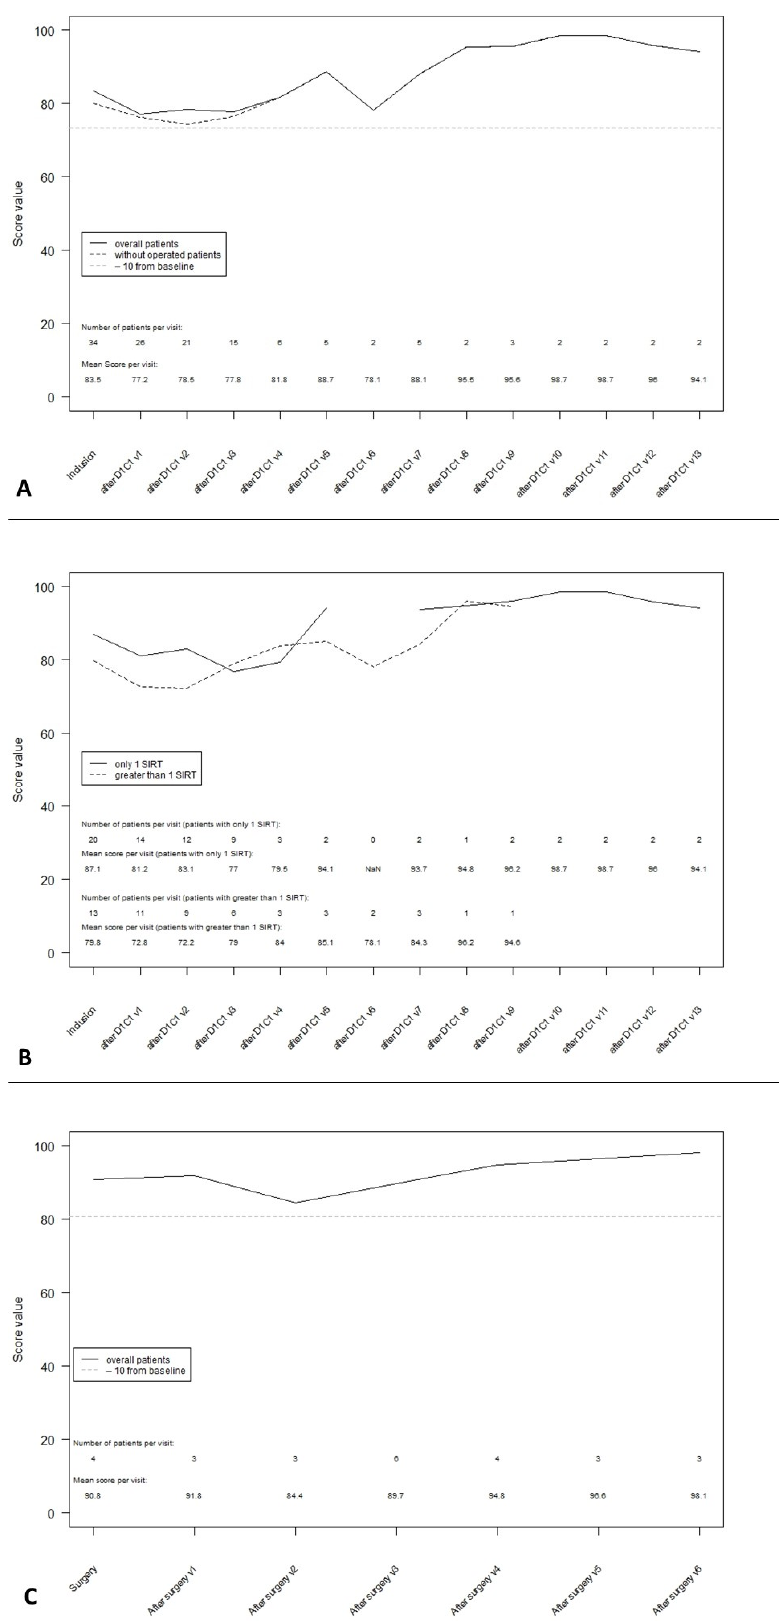
Figure 4. QLQ-C30 summary score during follow-up. ( A ): QLQ-C30 summary score in ITT overall population. ( B ): QLQ-C30 summary score according to the number of SIRT sessions received. ( C ): QLQ-C30 summary score